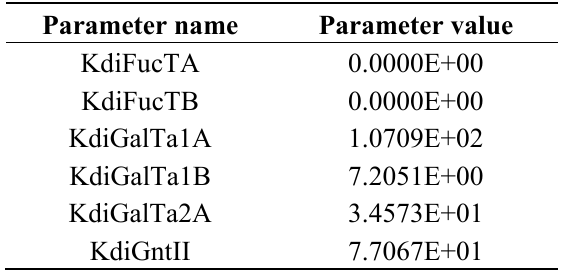
Table A6. N -linked antibody constant region glycan parameters.